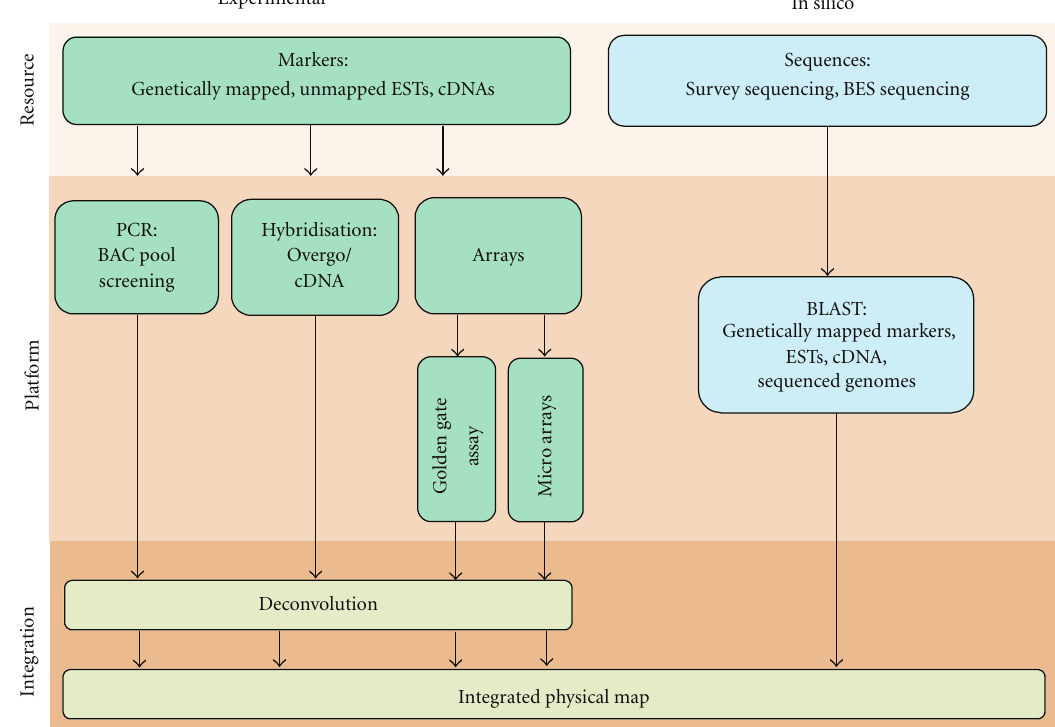
Figure 1: Approaches to BAC library screening. Genetically mapped markers and unmapped sequence information such as cDNA and ETSs can be used to screen multidimensional BAC pools via PCR-based methods, hybridization of BAC filters, or highly parallel array platforms. The resulted data are deconvoluted to obtain marker BAC relationships prior to integrating to the contig map. Alternatively the BAC sequence information obtained through survey sequencing (NGS/Sanger sequencing) or BES could be searched against genetically mapped markers, ESTs, cDNA, and so forth of the same organism or di ff erent